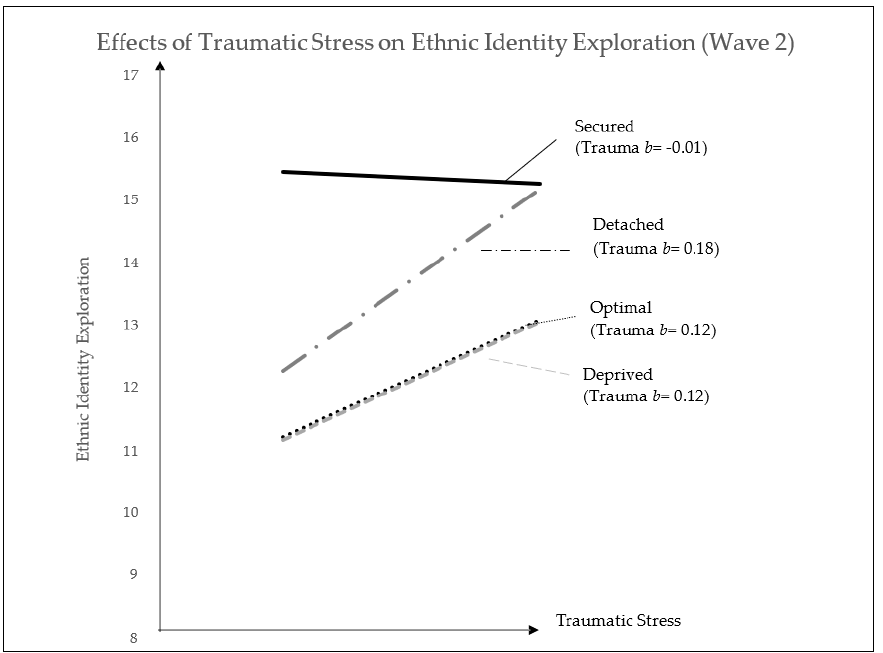
Figure 4. Effects of traumatic stress on ethnic identity exploration, according to relationship patterns with caregivers.